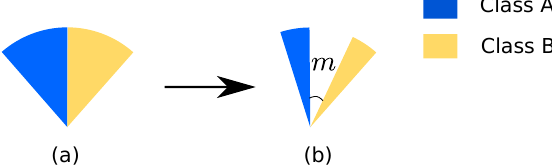
Figure 2. ( a ) The class boundary produced by the traditional softmax loss. ( b ) The class boundary produced by the normalized softmax loss with